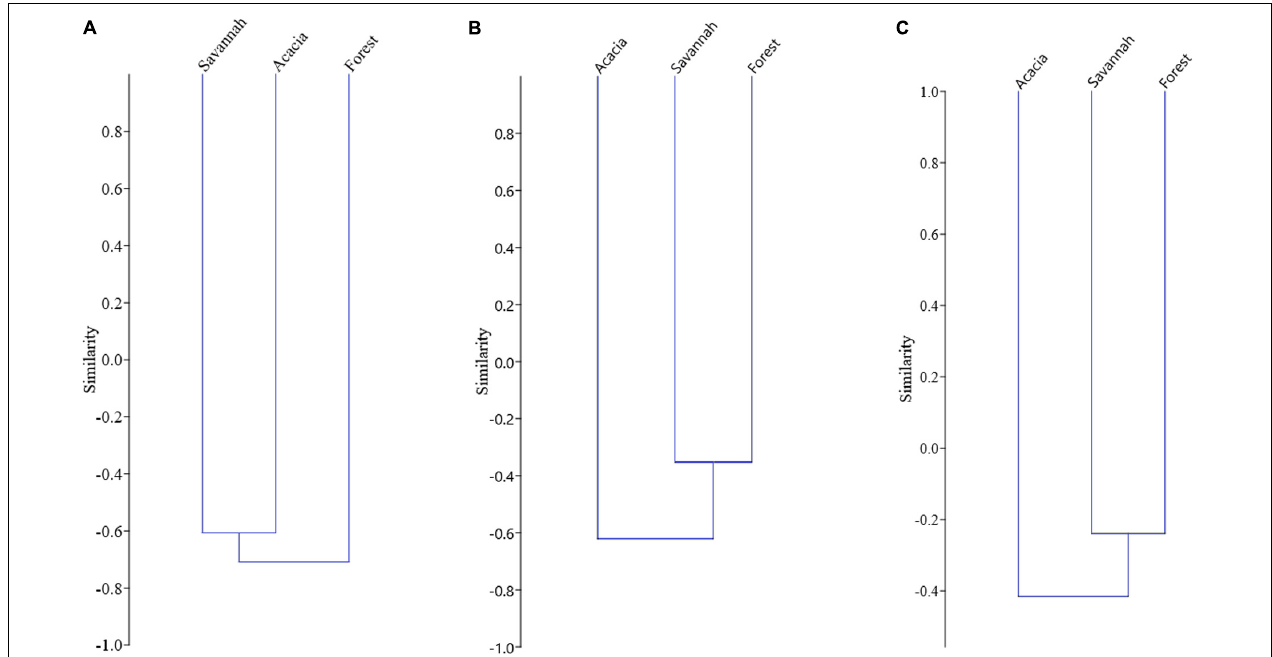
FIGURE 4 | Unweighted Pair Group Method with Arithmetic Mean (UPGMA) clustering of values of (A) taxonomic, (B) functional, and (C) phylogenetic β -diversity for bat assemblages sampled in the forest, savannah, and acacia plantations in an Amazonian savannah in the northern Brazilian Amazonia in 2017.